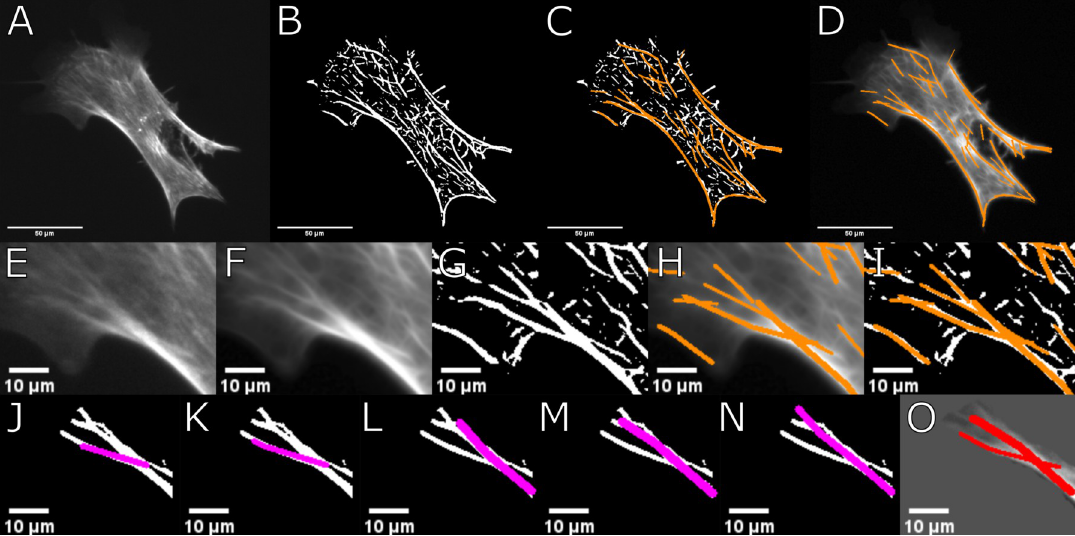
Fig 1. CurveTracer class step-wise illustration. A : Raw image of example cell. B : Binarized image of example cell. C : Filaments recognized by FS2.0 shown in binarized image. D : Found filaments shown as overlay of raw image. E : Cropped example region of cell shown in A. F : Output of filter routine preparing raw image for filament detection. G : Binarized image of example region. H : Altered image and found filaments overlayed in orange. I : Found filaments in binarized image and overlayed in orange. J-N : Visualised examples of different potential filaments found by curve tracer glass gather function. O : Final filaments found by curve tracer class after correction and weighting of all possible filaments generated.